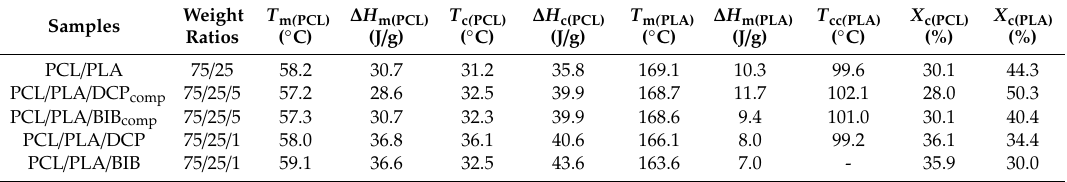
Figure 5. DSC second heating curves ( A ) and DSC cooling curves ( B ) of PCL / PLA blends. Table 2. Thermal properties of PCL / PLA blends.